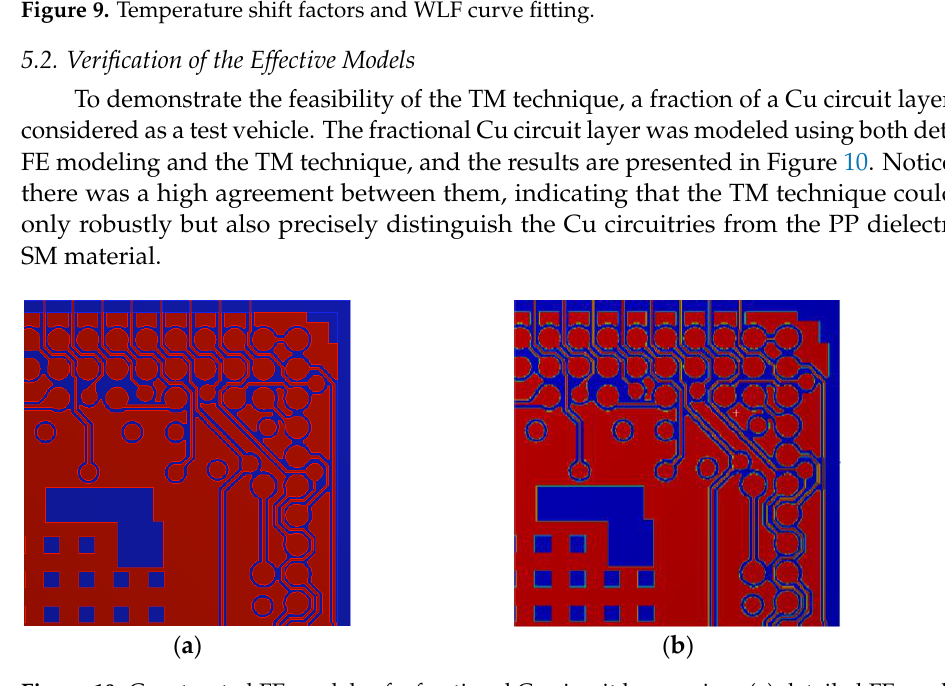
Figure 10. Constructed FE models of a fractional Cu circuit layer using: ( a ) detailed FE modeling; ( b ) TM method. Table 2. Comparison of calculated effective elastic moduli (MPa) using three different approaches.